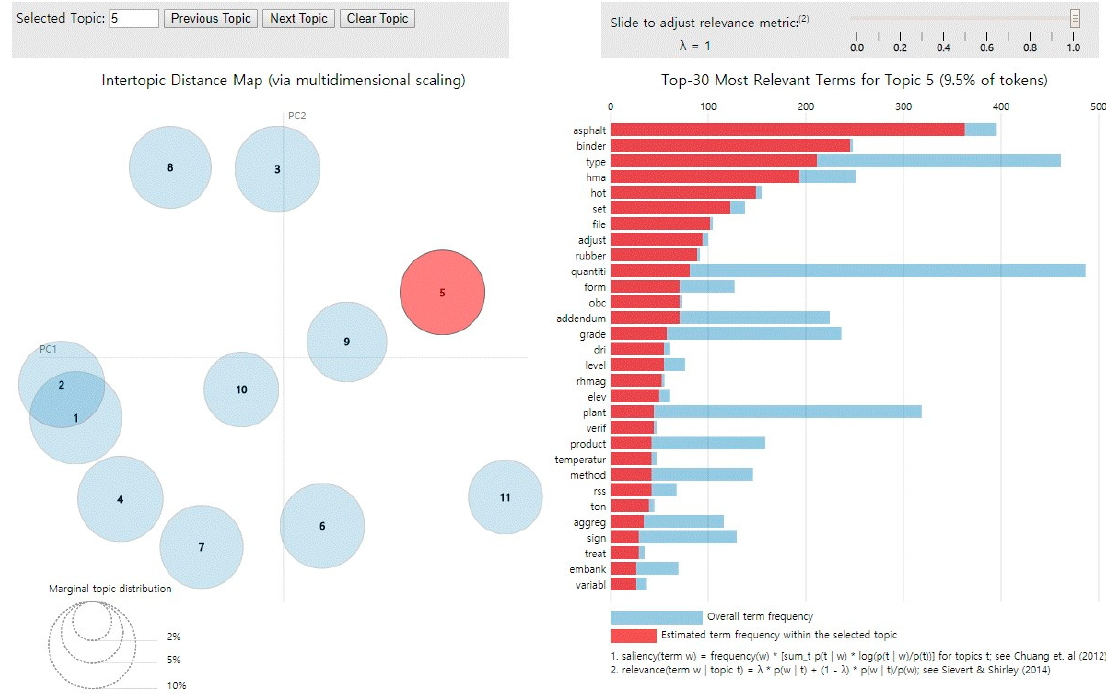
Figure 5. Topic Modeling Results using Latent Dirichlet Allocation (LDA).